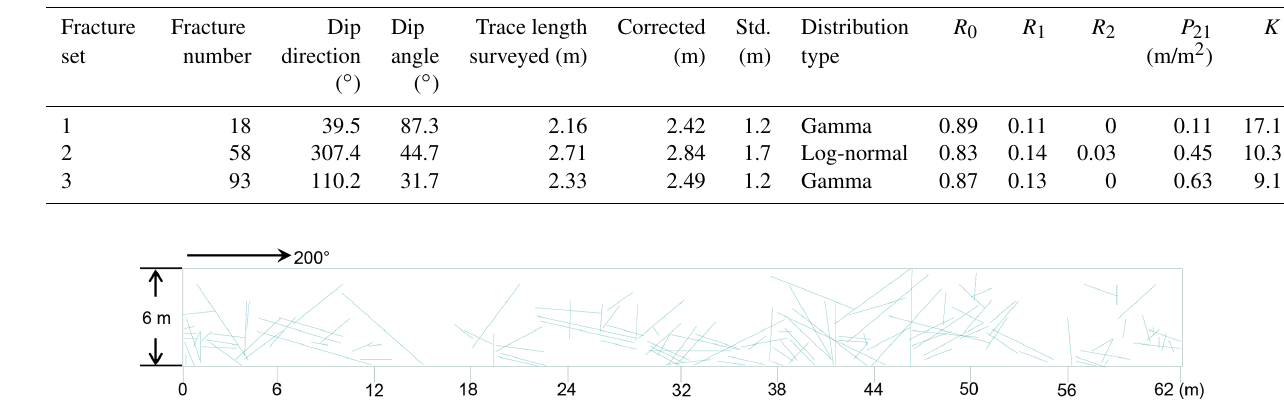
Table 1. Parameters for discrete fracture network (DFN) simulation.